Question: Provide a one-line summary of what is displayed.
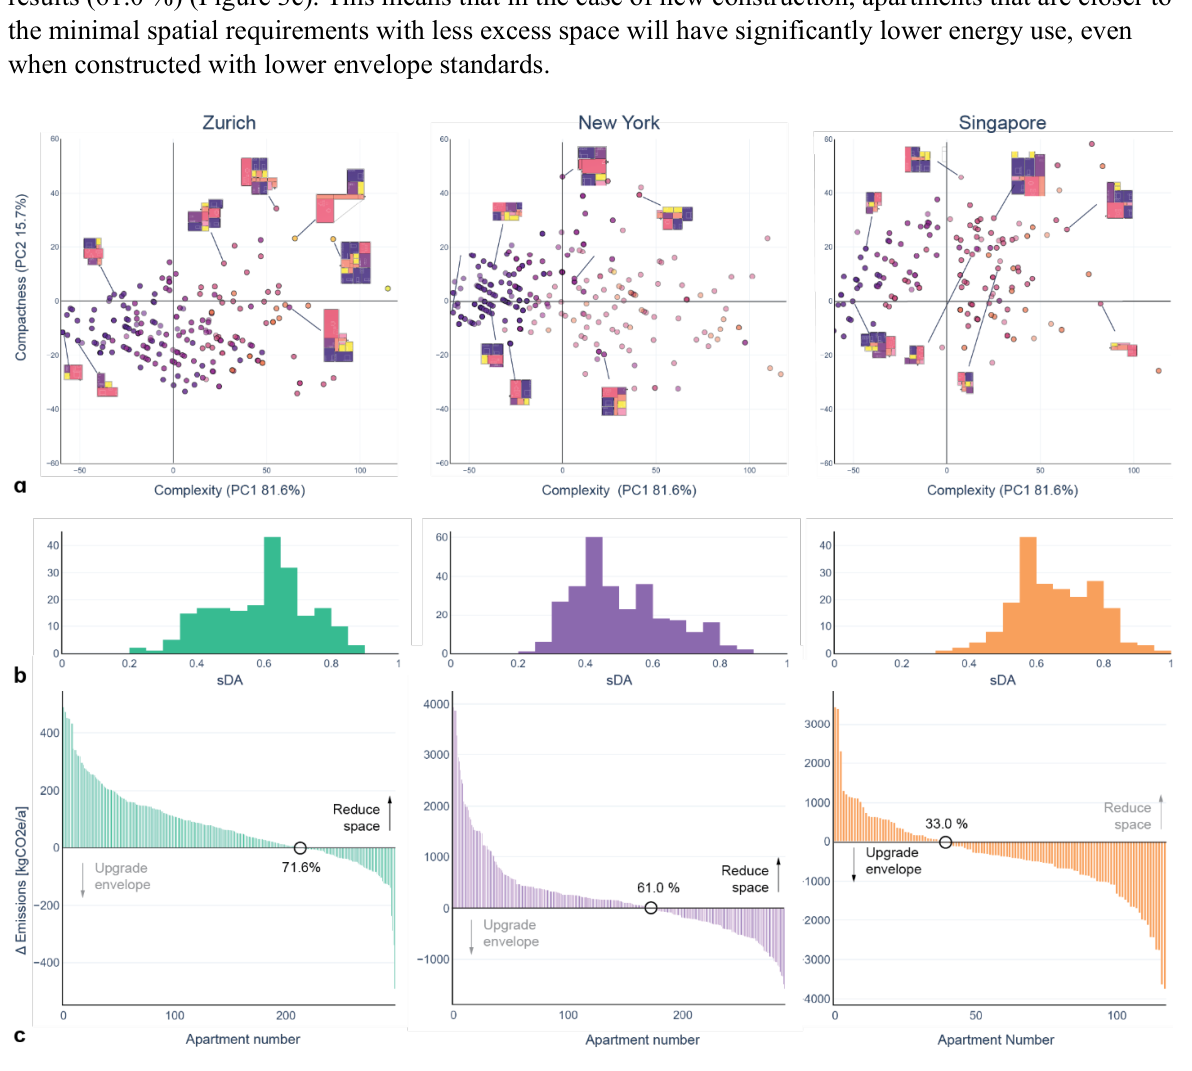
Answer: Mapping of all floor plans of Zurich, New York and Singapore with their graph structure (a) and sDA performance (b).  Comparison of emission from excess space compared with envelope upgrades (c) from the calibrated dataset (see 5.1.   Residential building floor plan repository).